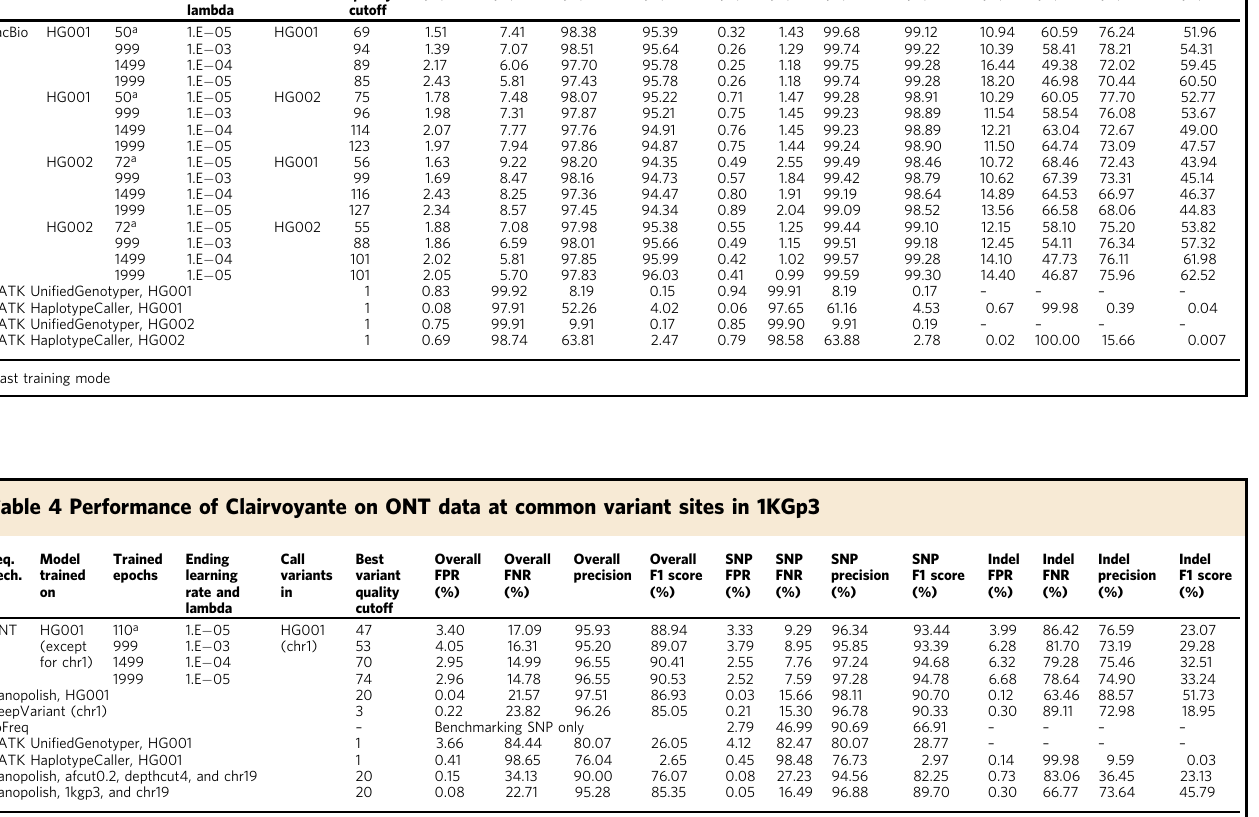
Table 3 Performance of Clairvoyante on PacBio data at common variant sites in 1KGp3 Seq. Model Trained tech. trained epochs on